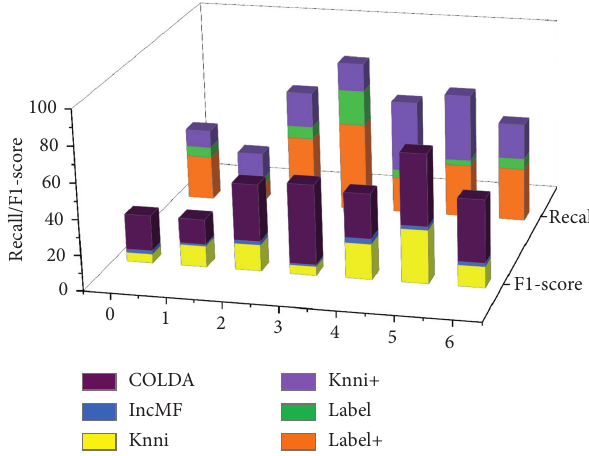
Figure 6: Comparison of datasets,